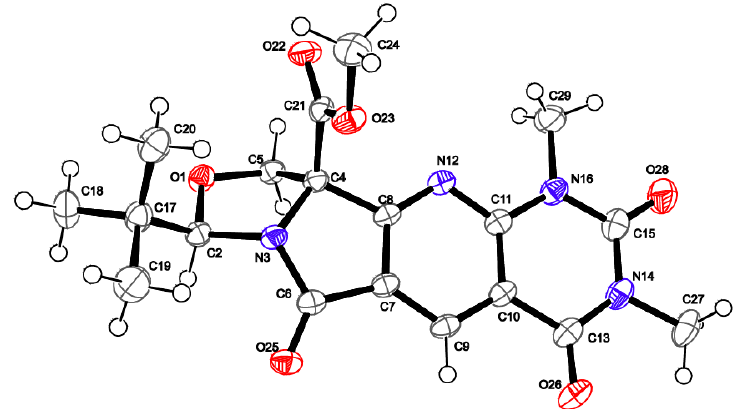
Figure 2. The crystal structure of compound 9a with the ADPs shown at 50% probability. The second molecule has been omitted for clarity.